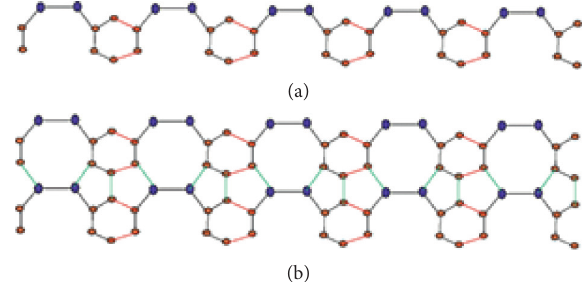
− III [ p, q ] : (a) SiC 3